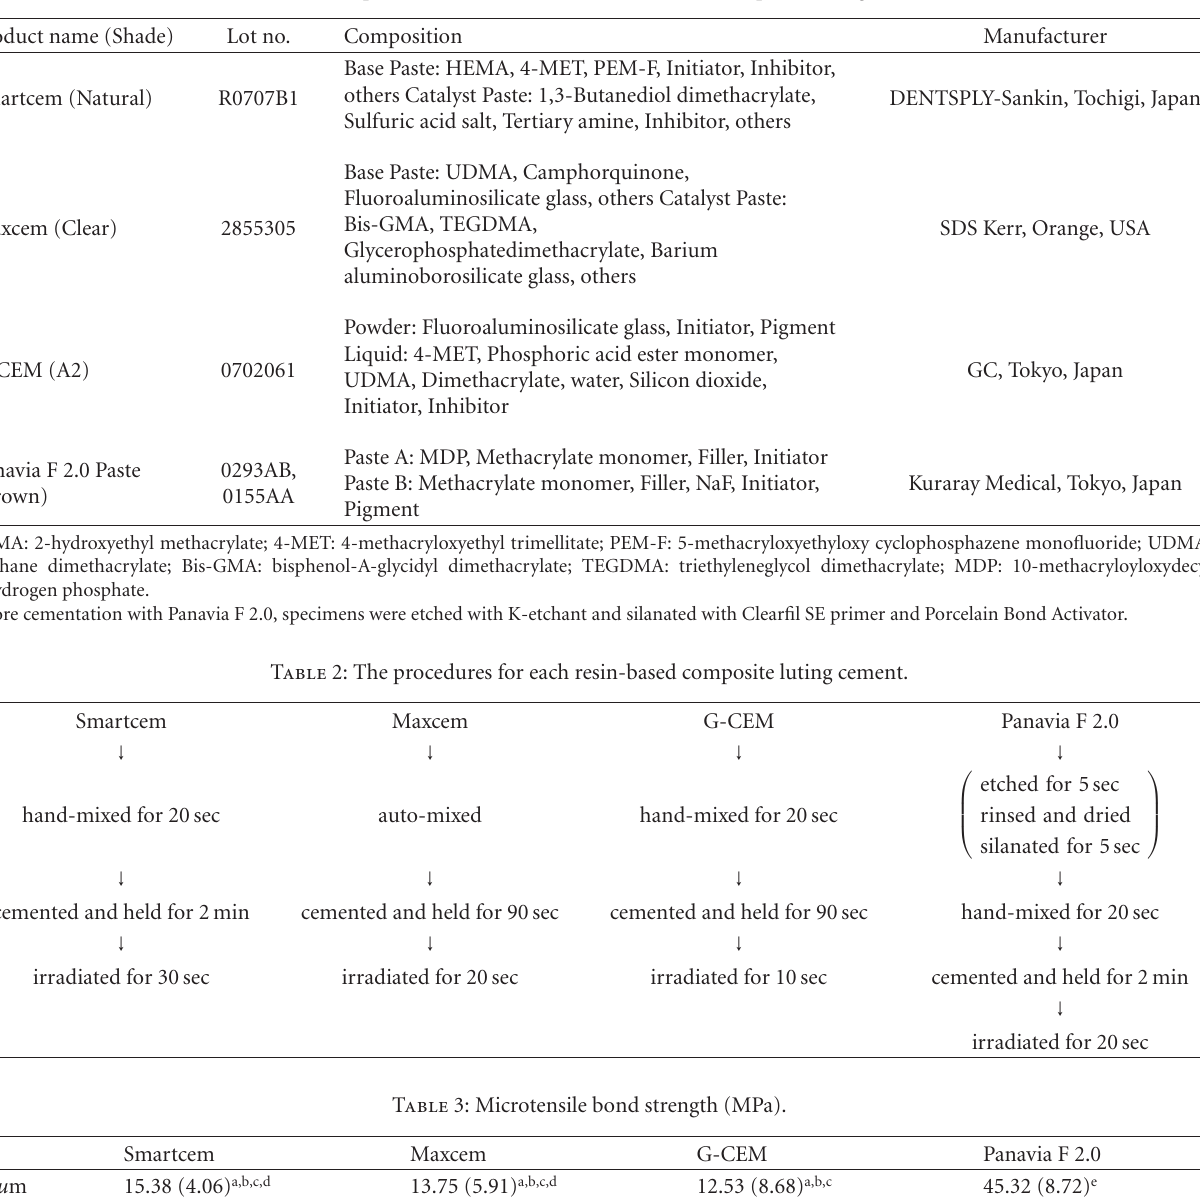
Figure 1: Schematic illustration of the procedure for core resin preparation. Table 1: Composition of the commercial resin-based composite luting cement.